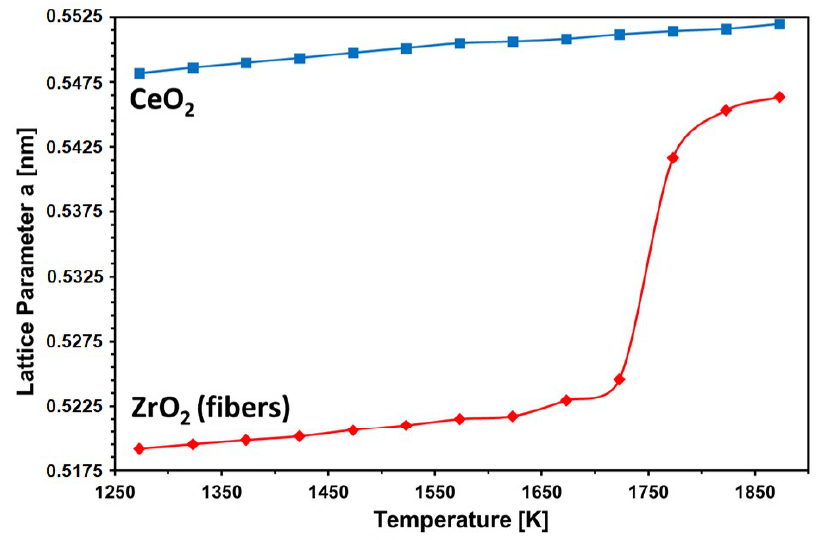
Figure 7. Lattice constant calculation of CeO 2 and YSZ as function of temperature.